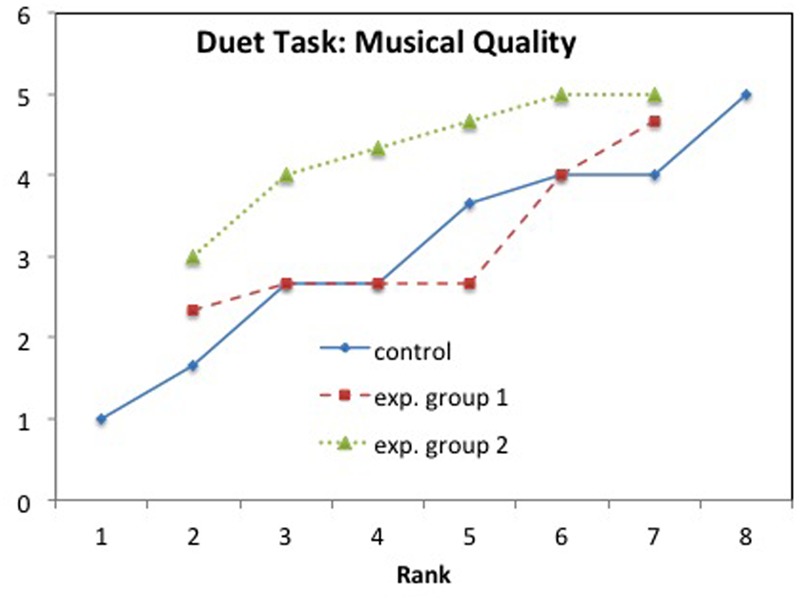
Duet task: Mean values rank-ordered in each group for Musical Quality.